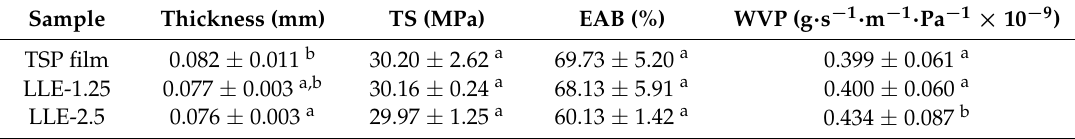
Table 1. Mechanical properties and water vapor permeability (WVP) values of the pH-sensing